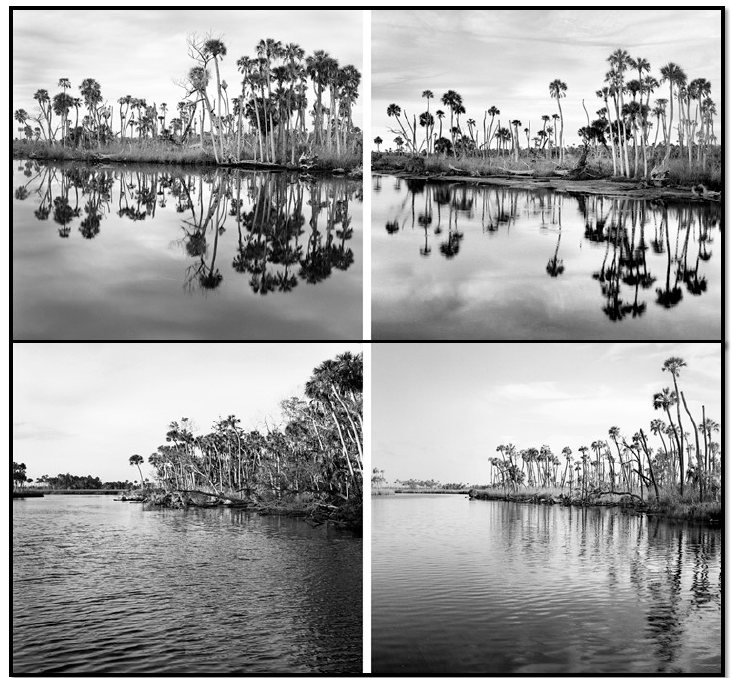
Figure 2. Before and after photographs of two sites (see Figures 3 and 4) within the study area. ( Top ) Site 1 showing photographs from 2011 ( left ) and 2016 ( right ). ( Bottom ) Site 2 showing photographs from 2004 and 2015. The photos reveal a thinning of tree stands and loss of canopy cover at both sites (© Copyright Benjamin Dimmitt).